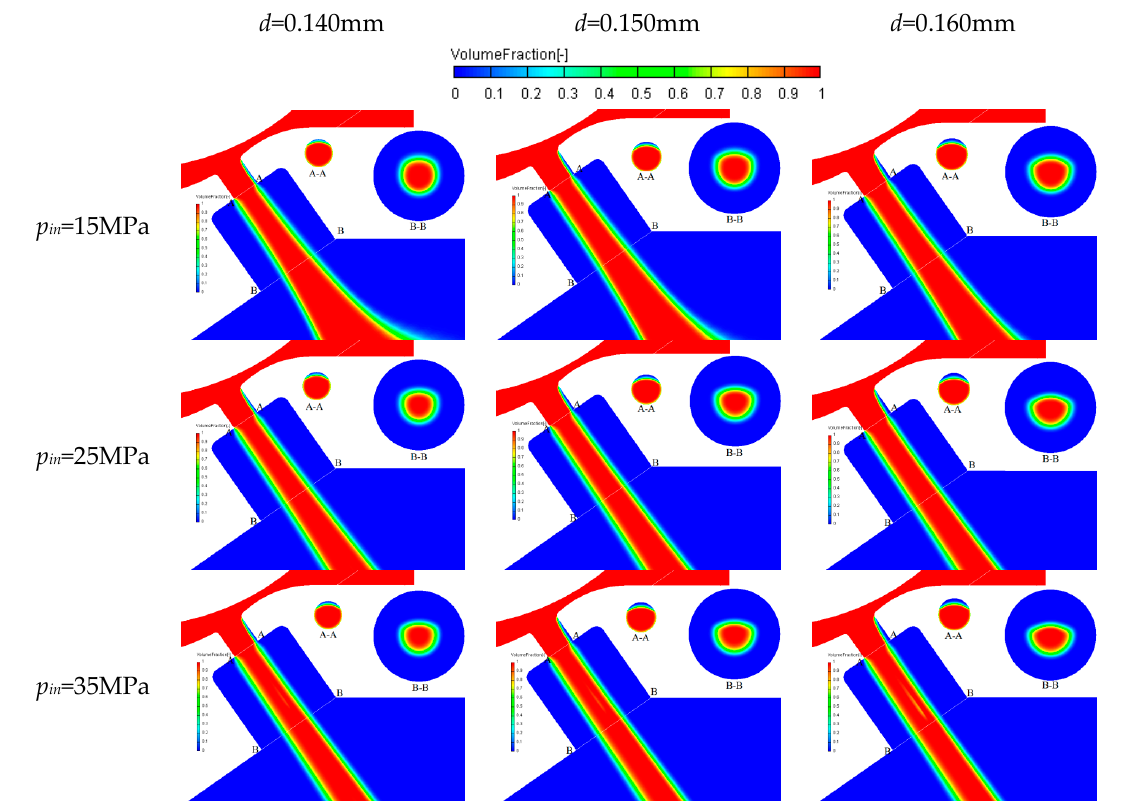
Figure 11. Effects of injection pressure and nozzle diameter on near-nozzle flow.